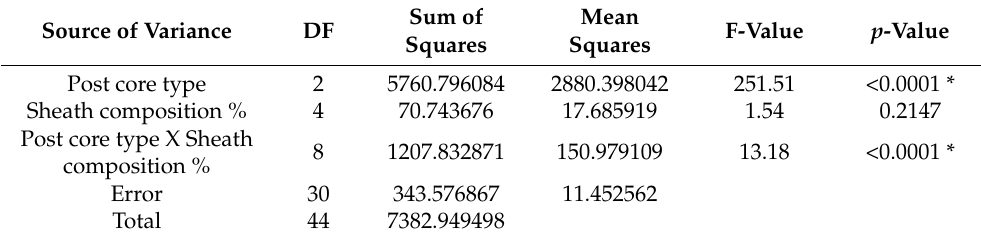
Table 2. Two-way ANOVA showing the effect of both post core type and sheath composition percentage on two-point bending flexural strength (Compression at 45 ◦ ) of fiber composite